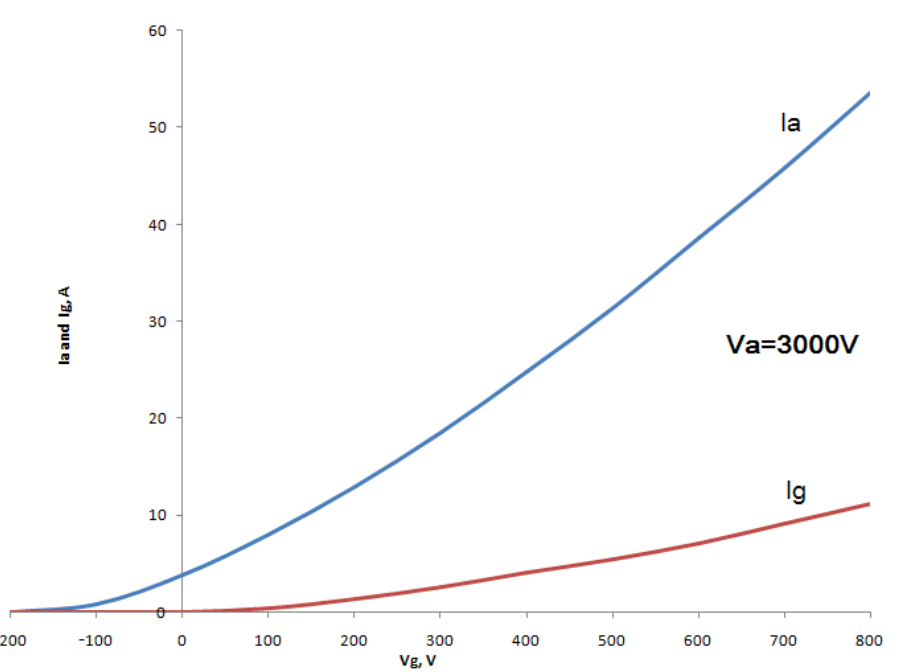
Figure 2. Chart of anodic current dependence on anode voltage at constant grid voltage.